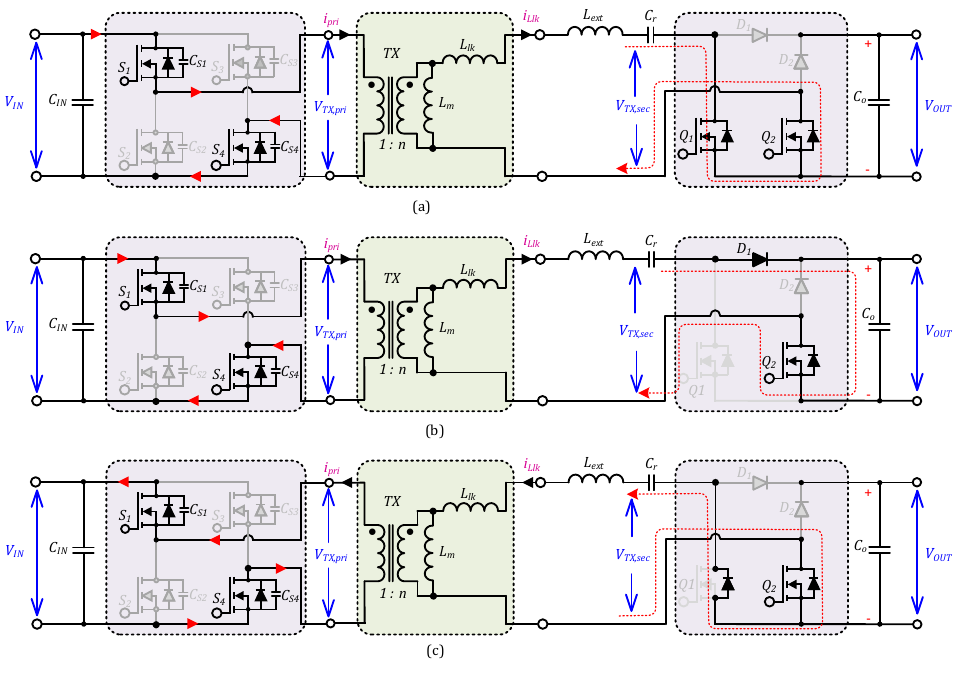
Figure 4. Operating modes of the converter during a one-half cycle with the overlapping modulation at ∆𝑉 𝐶𝑟 > 2𝑛𝑉 𝐼𝑁 : ( a ) Mode I; ( b ) Mode II; ( c ) Mode III.